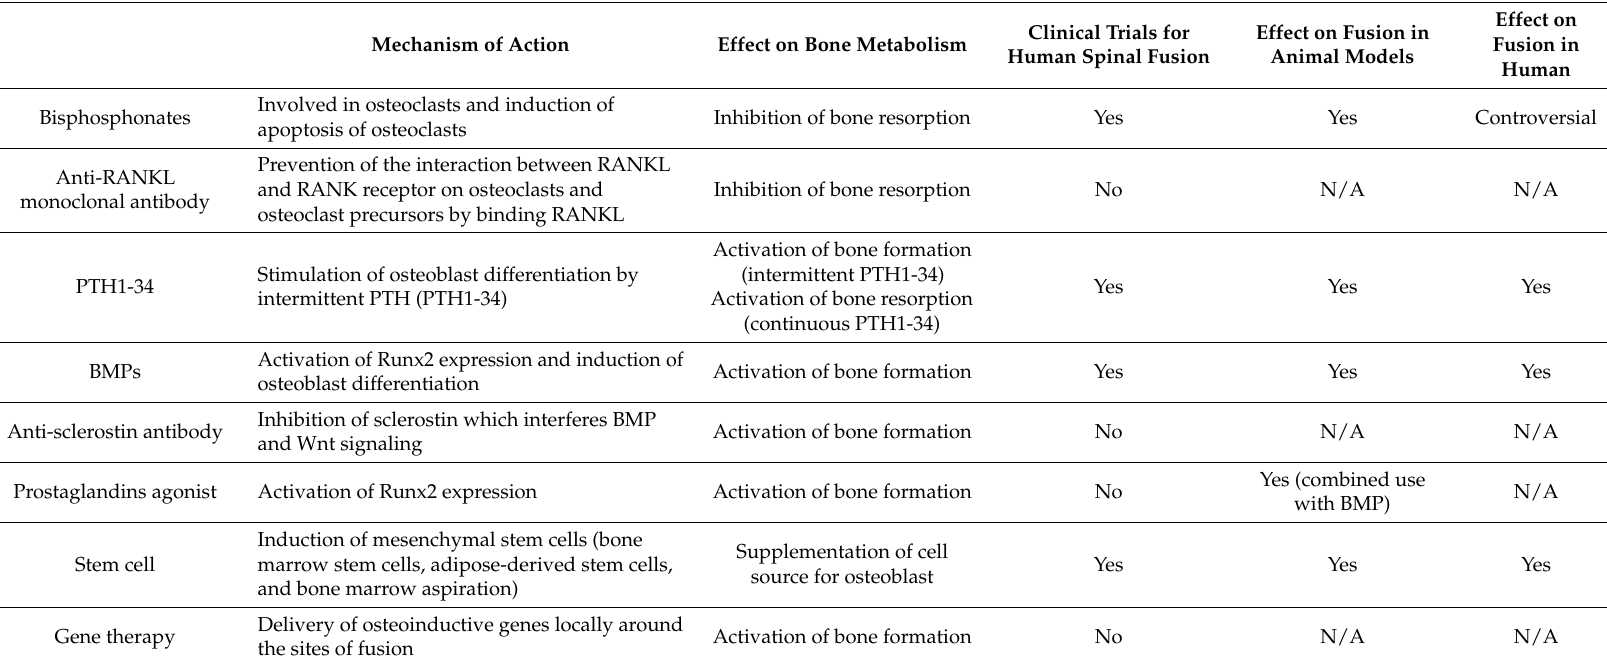
Table 1. The summary of approaches for biological enhancement of spinal fusion identified in this